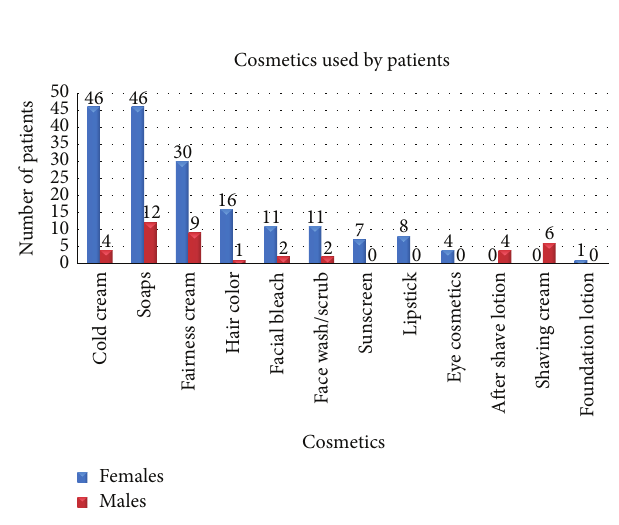
Figure 1: Common cosmetics used by the patients.